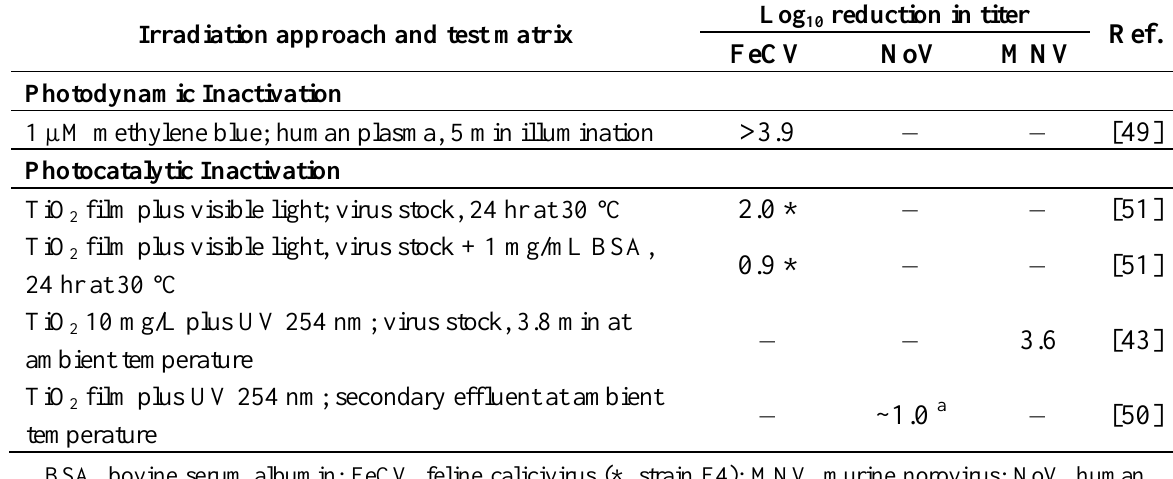
Table 3. Photodynamic and photocatalytic inactivation of